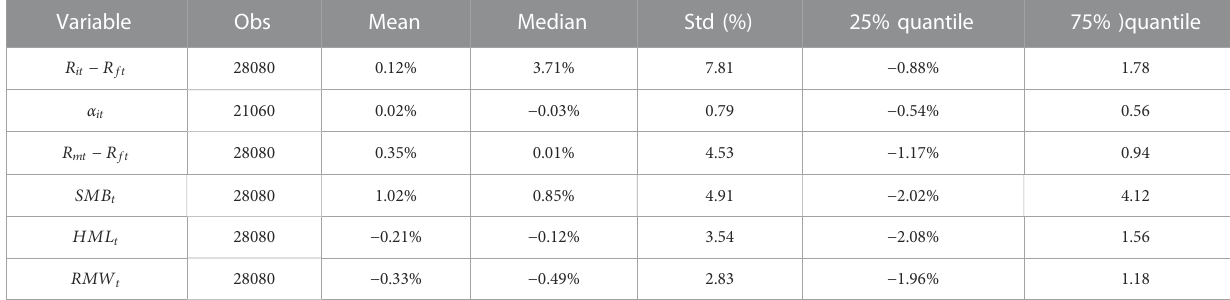
TABLE 1 Summary statistics of the Fama – French fi ve-factor model.